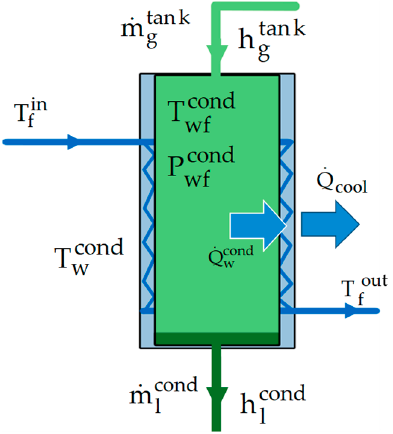
Figure 5. Schematic of condenser modeling.